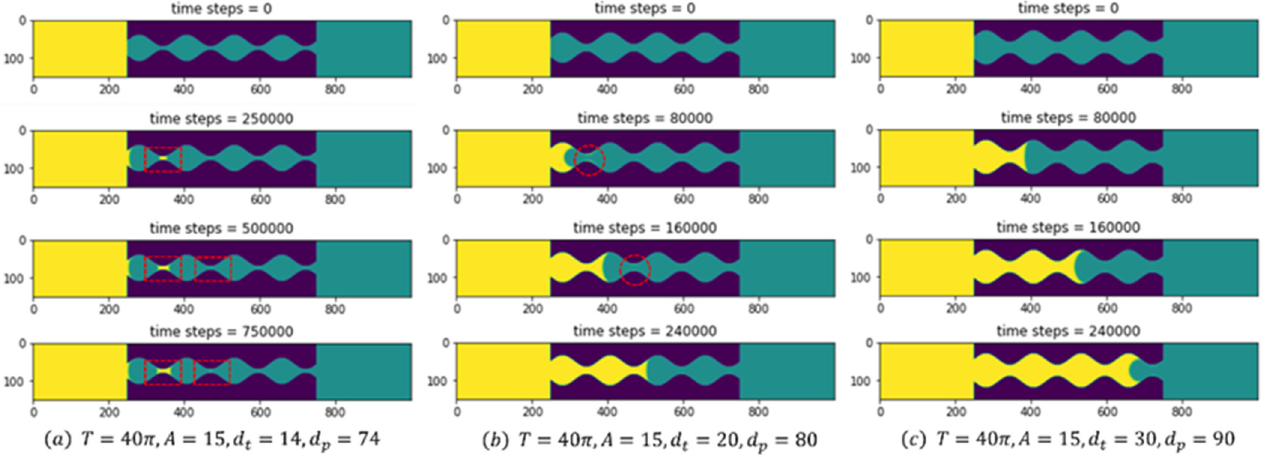
Figure 12. The snapshots of simulated spontaneous imbibition processes in the variable-diameter capillaries.